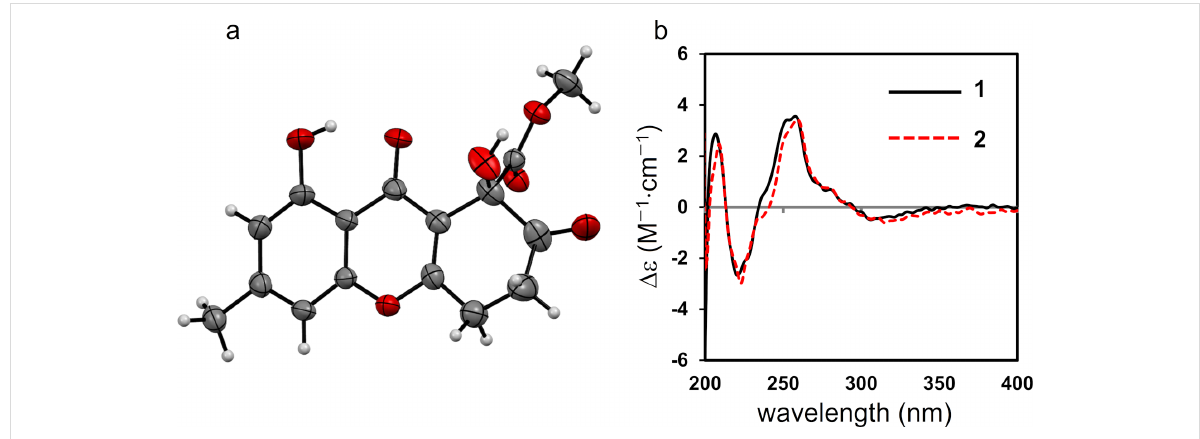
Figure 3: a) ORTEP drawing of 1 , with thermal ellipsoids indicating 50% probability. The atoms of the minor disordered component have been omitted for clarity. b) Electronic circular dichroism spectra of 1 (black solid line) and 2 (red dashed line).